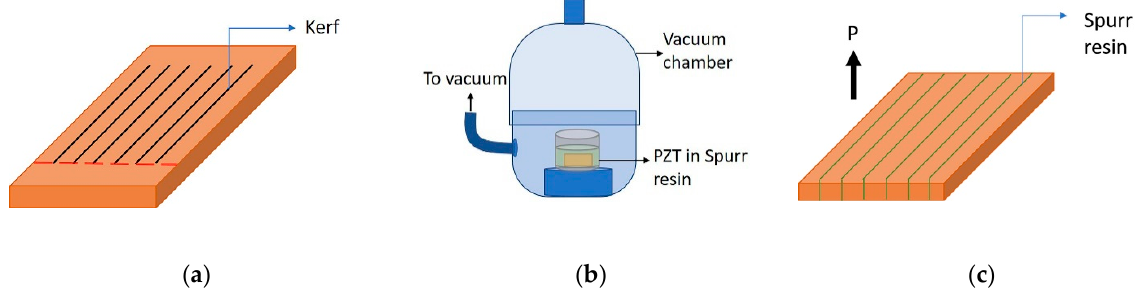
Figure 3. Illustration of the process to fabricate PZT–polymer 2-2 composite. ( a ) Shows the kerfs formed in PZT after etching the ZnO layers. The sample was diced along the red dotted lines marked on the PZT. ( b ) Illustrates the epoxy backfilling process. ( c ) Shows the 2-2 composite prepared after backfilling it with Spurr resin and polishing. The black arrow in ( c ) shows the poling direction.